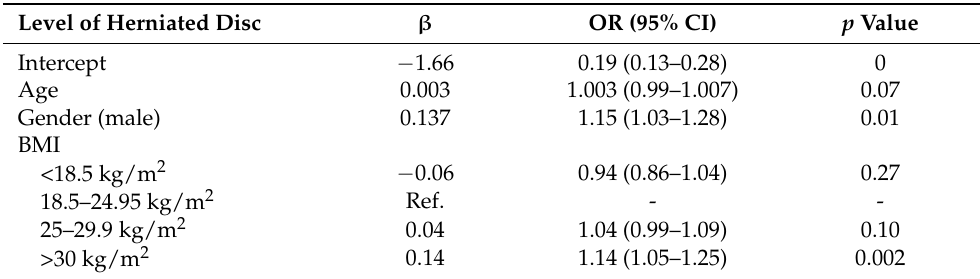
Table 3. Factors associated with KAP: results from the GLM. Level of Herniated